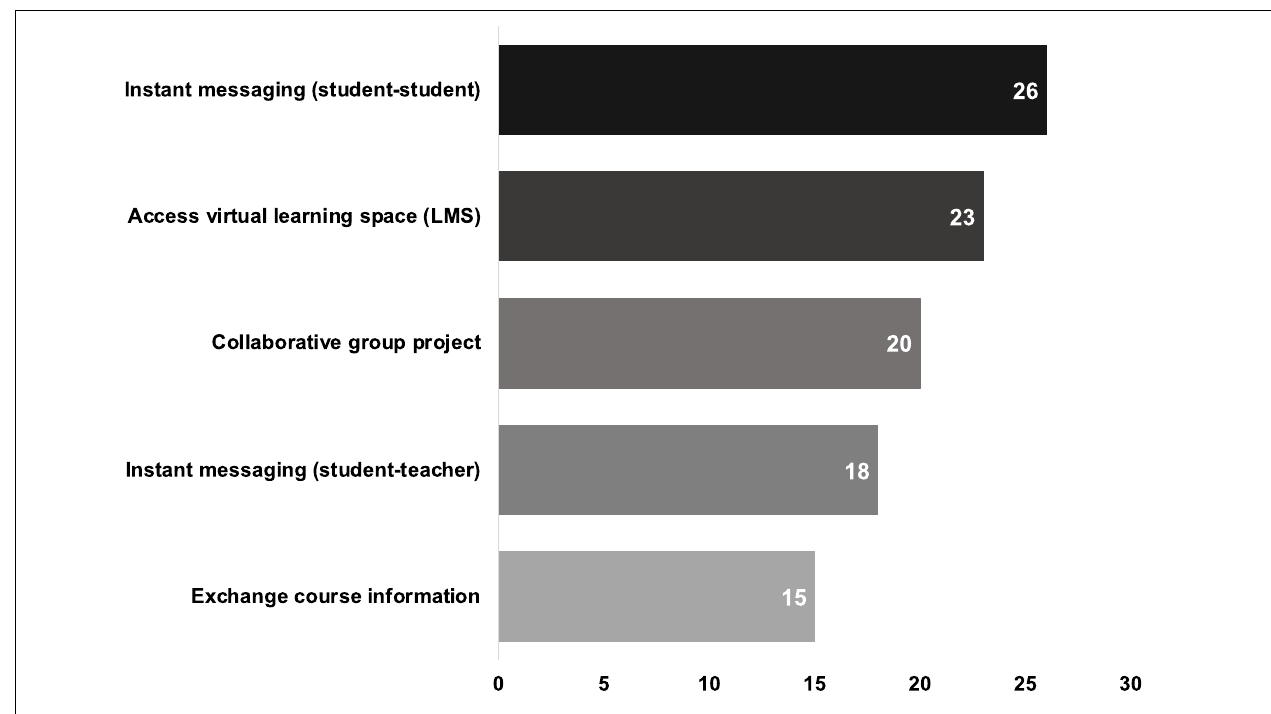
FIGURE 2 | Social media types of usage as reported by the interviewees (based on empirical